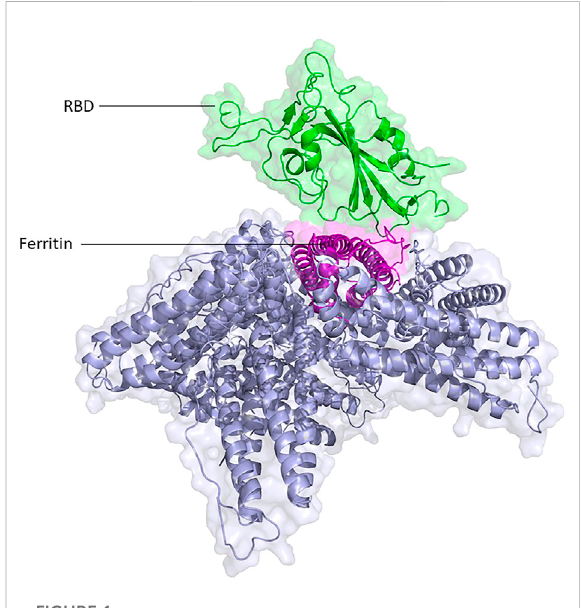
FIGURE 1 Structural presentation of RBD attached to one unit of ferritin among its eight units. RBD and ferritin are shown in green and purple, respectively. Ferritin self-assembled units are shown in